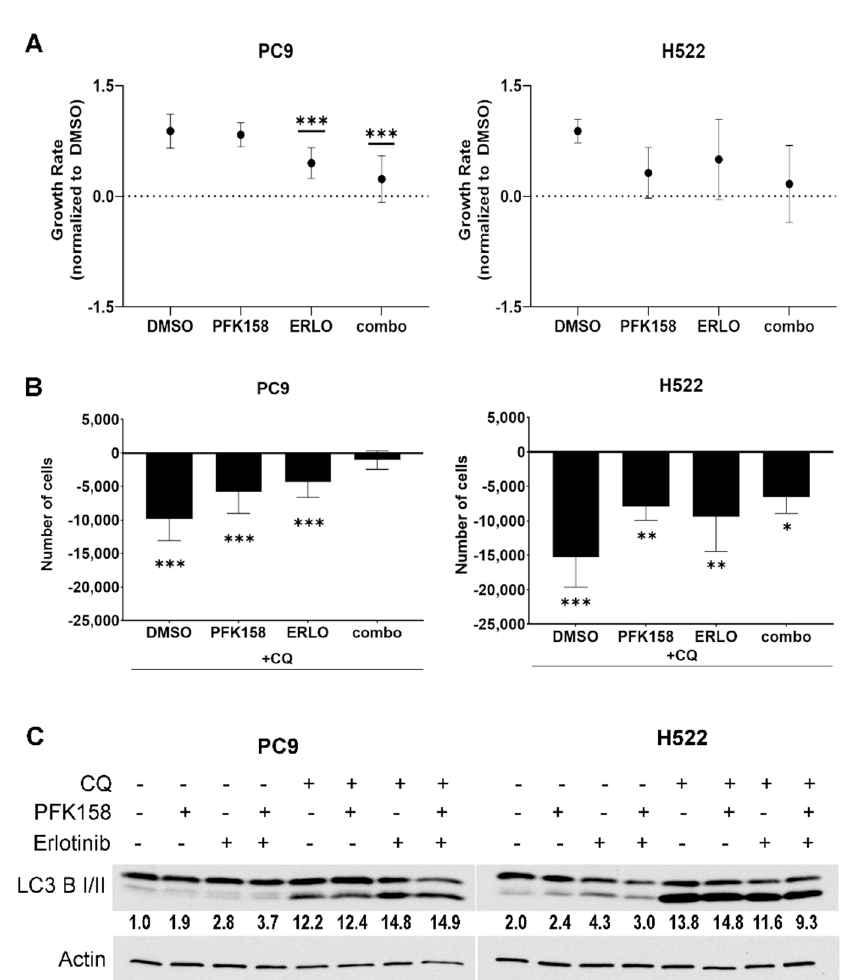
Figure 1. Basal and drug-induced autophagy is essential for cell growth in NSCLCs exposed to EGFR or PFKFB3 inhibitors. PC9 and H522 cells were exposed to erlotinib (0.5 µ M or 2 µ M, respectively) and/or PFK158 (5 µ M or 1 µ M, respectively) alone or in combination with the autophagy inhibitor chloroquine (CQ, 100 µ M) for 24 h. Growth rates (GR) were calculated as indicated in Methods, where GR > 0 indicates inhibited growth, GR = 0, cytostatic effect and GR < 0, cytotoxic effect. Error bars, mean ± S.D. of two independent experiments (n = 6). p values are shown as follows: *** < 0.001 (compared to DMSO treatment) ( A ). The difference in number of cells in response to the presence of chloroquine in appropriate treatment was calculated and presented as delta in number of cells. Error bars, mean ± S.D. of two independent experiments (n = 6). p values are shown as follows: * < 0.05; ** < 0.01; and *** < 0.001 (compared to appropriate treatment without CQ) ( B ). PC9 and H522 cells were exposed to 100 µ M CQ for 4 h and levels of LC3 B II were evaluated in immunoblotting and are representative from three independent experiments ( C ). LC3 B II levels presented as normalized to actin and to the control treated cells (DMSO, PC9) [39] .